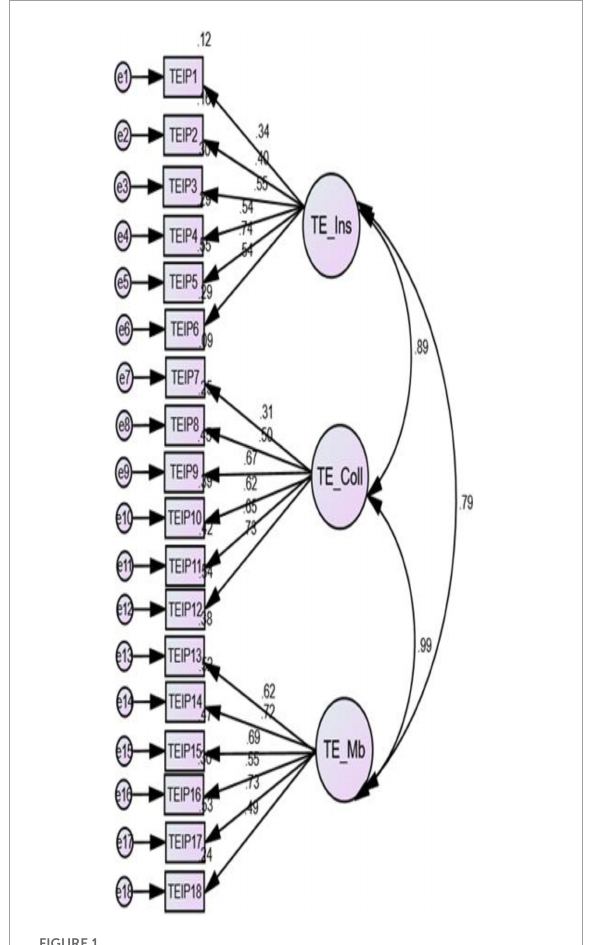
FIGURE1 Summary of confirmatory factor analysis.